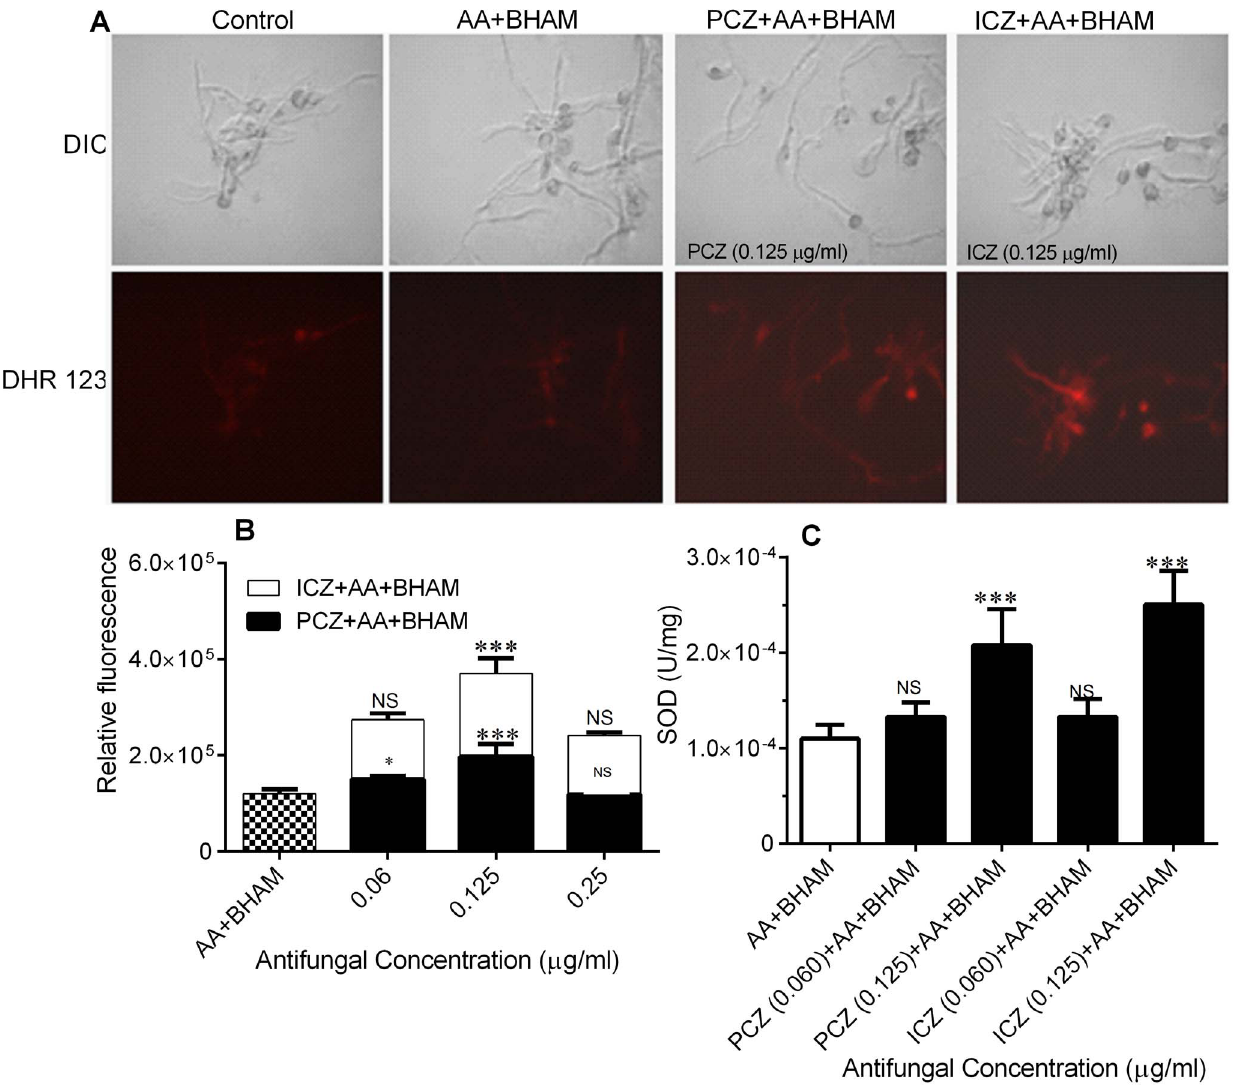
Figure 1. Intracellular ROS accumulation in R.oryzae germlings treated with PCZ or ICZ plus the mitochondrial inhibitors AA and BHAM, germlings treated with only AA and BHAM, and untreated control germlings stained with DHR-123 detected using fluorescence microscopy and a spectrophotometer. (A) Staining with DHR-123 showing increased red fluorescence. DIC, differential interference contrast. (B) Relative fluorescence of cells stained with DHR-123. The fluorescence was detected with excitation at 500 nm and emission at 550 nm. (C) SOD activity of treated and untreated control R. oryzae cells. P values for this and subsequent figures are denoted as follows: *, p , 0.05, **, p , 0.001, and ***, p , 0.0001, while NS, p . 0.05, compared to AA + BHAM treated controls. The experiments were performed in triplicate and repeated three times. Error bars indicate standard deviations for this and subsequent figures.